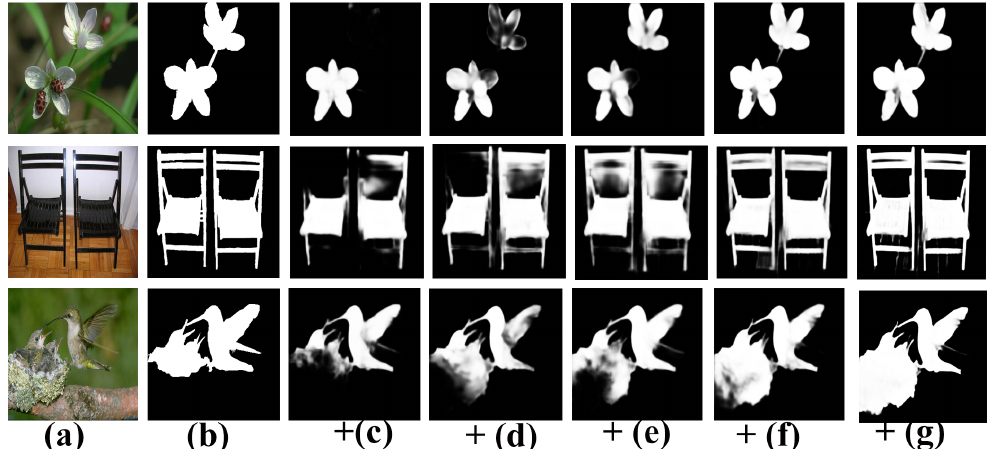
Figure 9. Examples of visual comparisons among the different modules of the proposed model: ( a ) input image, ( b ) ground truth, and ( c – g ) are saliency maps generated by the baseline (FPN), DFEUs, CFIUs, CSR, and CSR *.